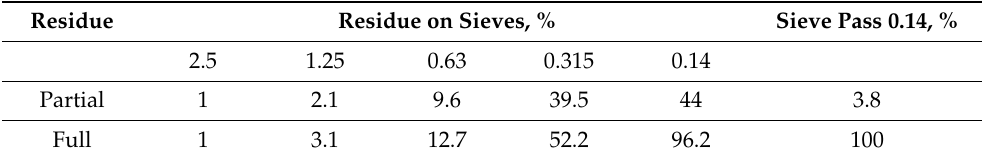
Table 1. Granulometric composition of the sand.